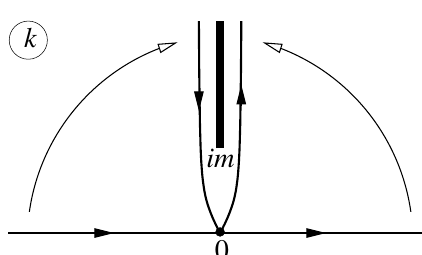
Figure 16. Contours in the k -plane used in the calculation of the Boulware Green’s function at positive x , x 0